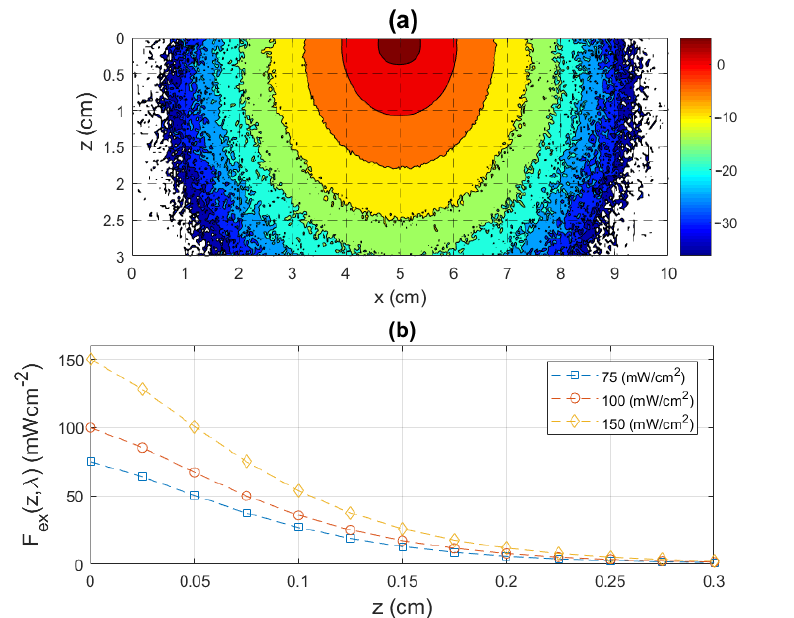
Figure 3. ( a ) Photons flux in logarithmic scale, resulting from Monte Carlo simulation at 630 nm, and ( b ) the light fluence rate as a function of depth ( z axis) for three different